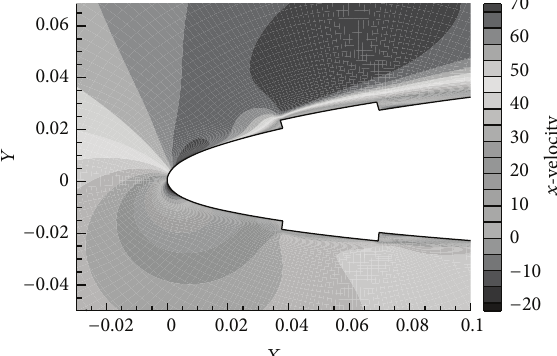
Figure 12: 𝑋 -velocity distribution of air around the 5% chordwise tripped airfoil.